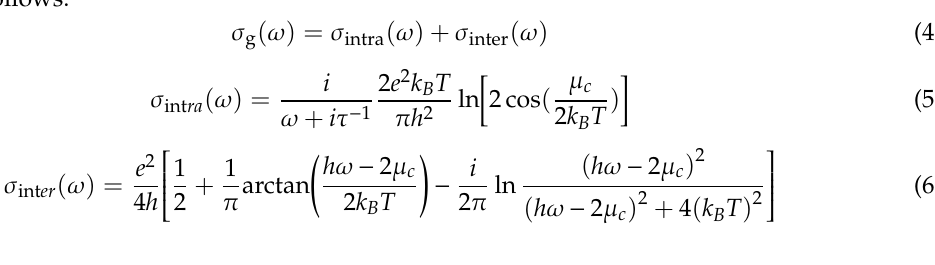
μ ) of graphene by c